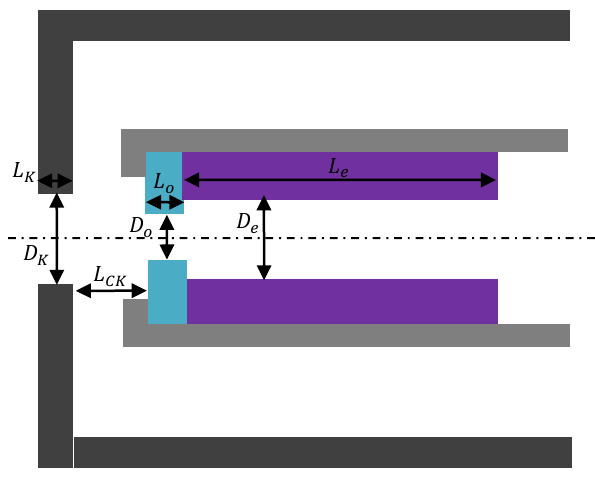
Figure 9 . Main geometrical features of an orifice hollow cathode. Figure 9. Main geometrical features of an orifice hollow